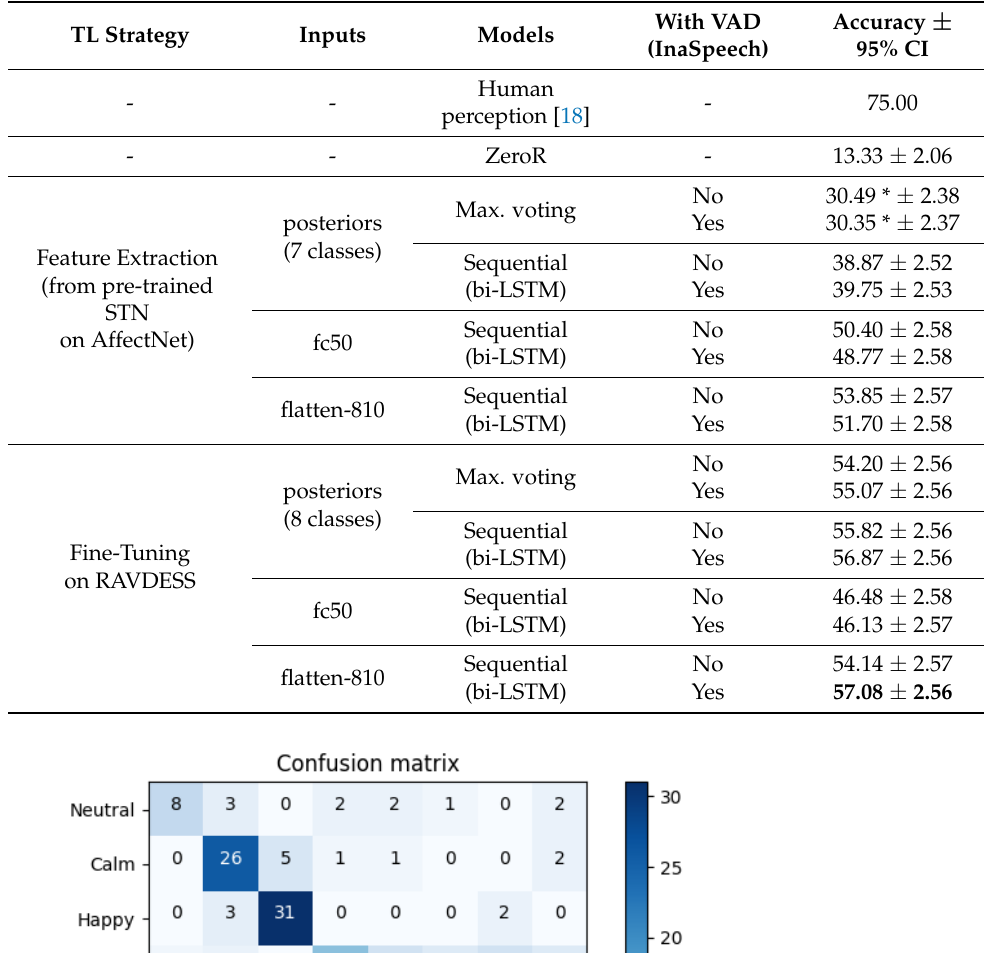
Table 3. Quantitative evaluation of the different strategies on the facial emotion recognizer. Results are given at the video level. All the results are reported on eight emotions except those that appear with (*), that are reported in seven emotions, collapsing the ‘Neutral’ and ‘Calm’ emotions. In bold, the best model.